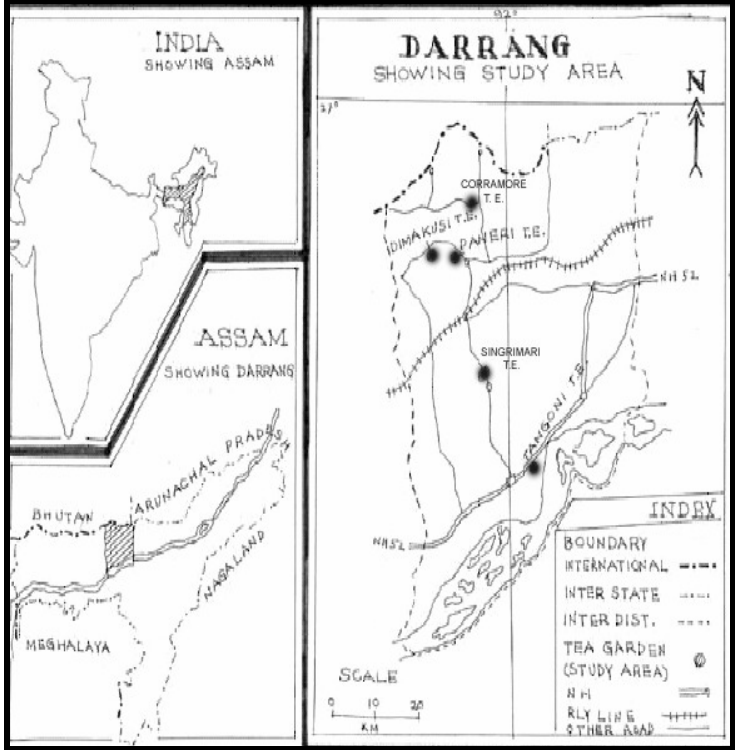
Figure 1. Sketch map of Darrang district showing its